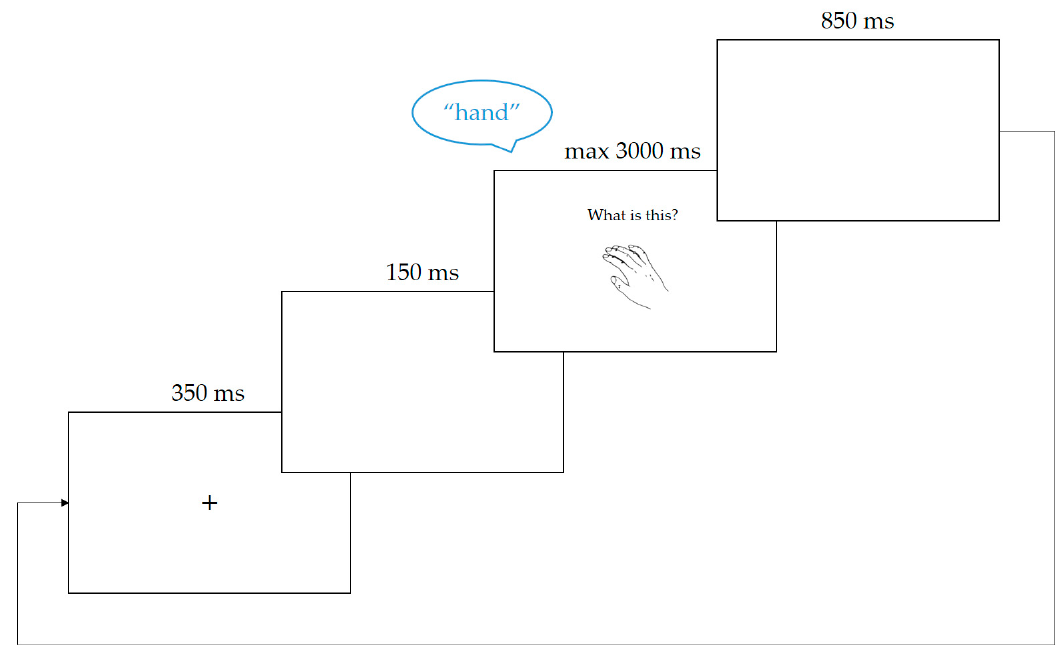
Figure 3. An example of a naming trial, showing the sequence of frames and the display of language cue (“what is this?”) and target stimulus (the picture of the hand). This example trial requires the response “hand” in English.